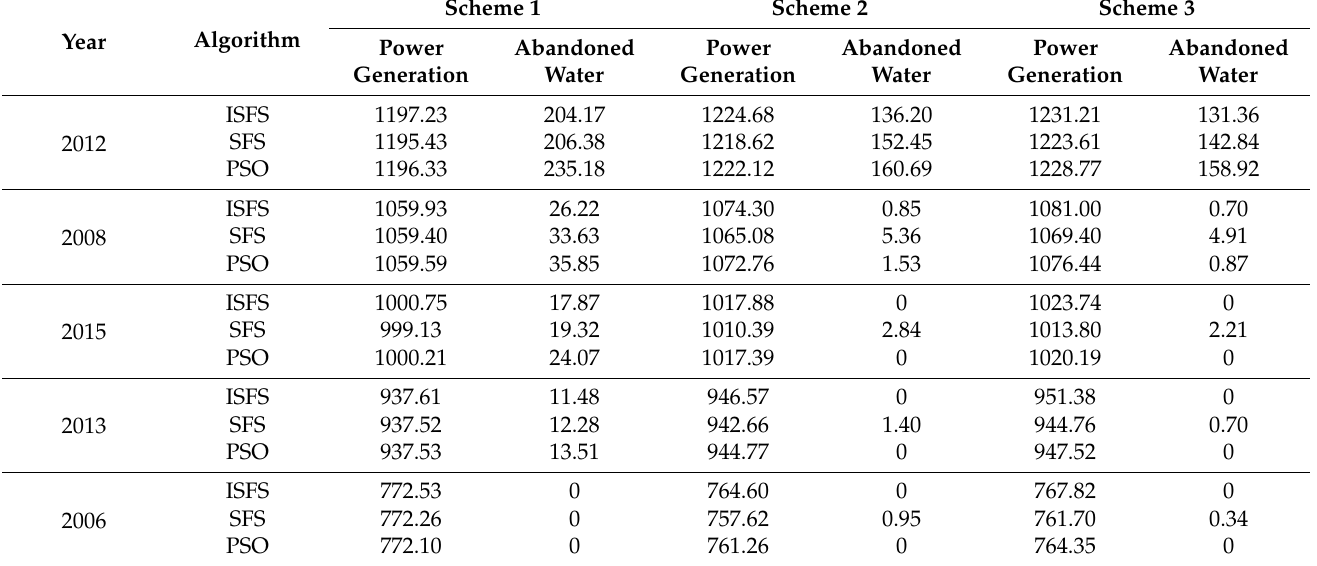
Table 2. Optimization results of the three schemes obtained by applying the ISFS algorithm, SFS algorithm and PSO algorithm in five typical